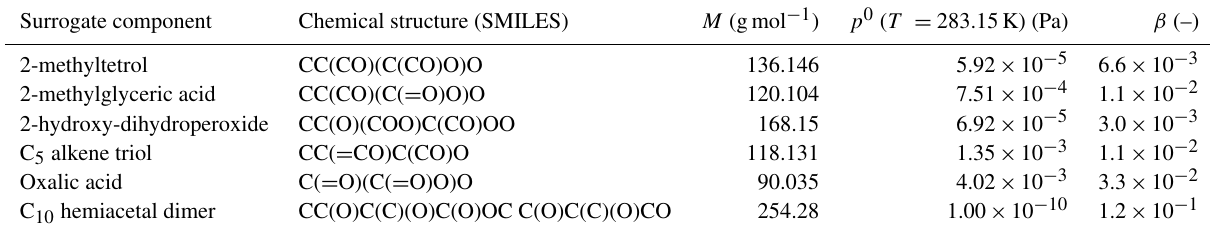
Table 1. Values of scaling parameters of the list of surrogate species used for the gas–particle partitioning calculations. For reference, a branching ratio value of β = 6 . 6 × 10 − 3 for 2-methyltetrol indicates that 0.66% of the predicted molar yield from the product’s cumulative parent species determine the yield of